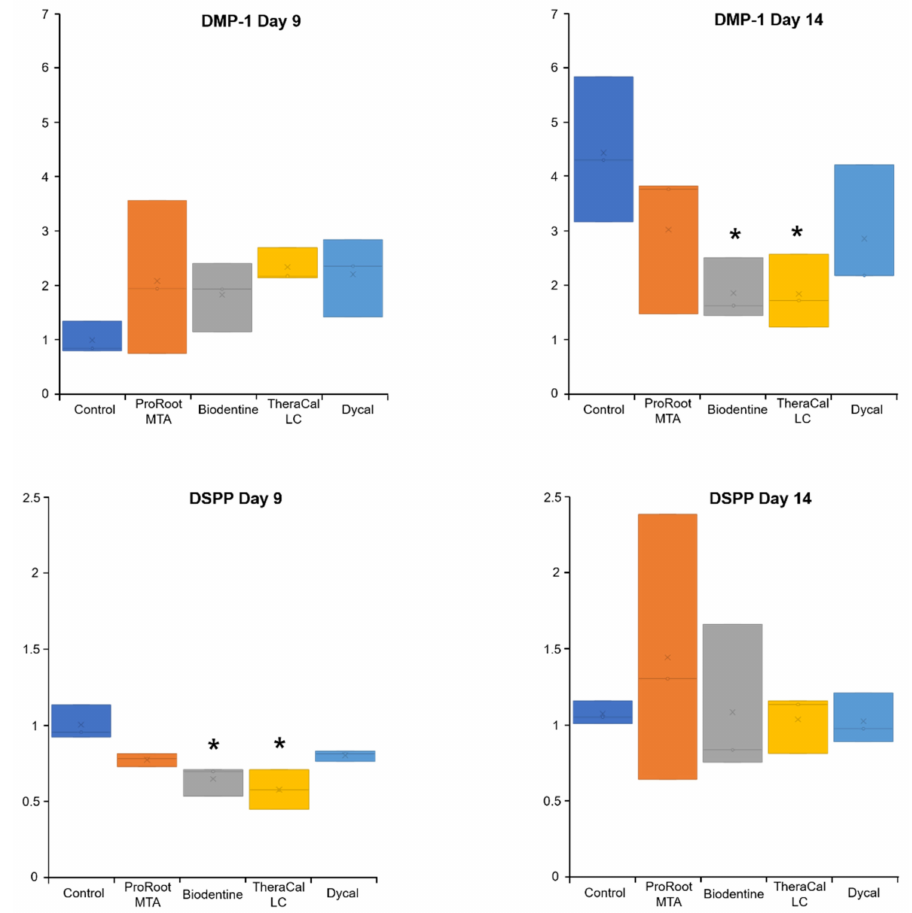
Figure 7. Relative expression levels of osteogenic genes, DMP-1 and DSPP , in hDPSCs incubated for ( left ) 9 and ( right ) 14 days with various pulp-capping materials. * Statistically significant difference between experimental and control